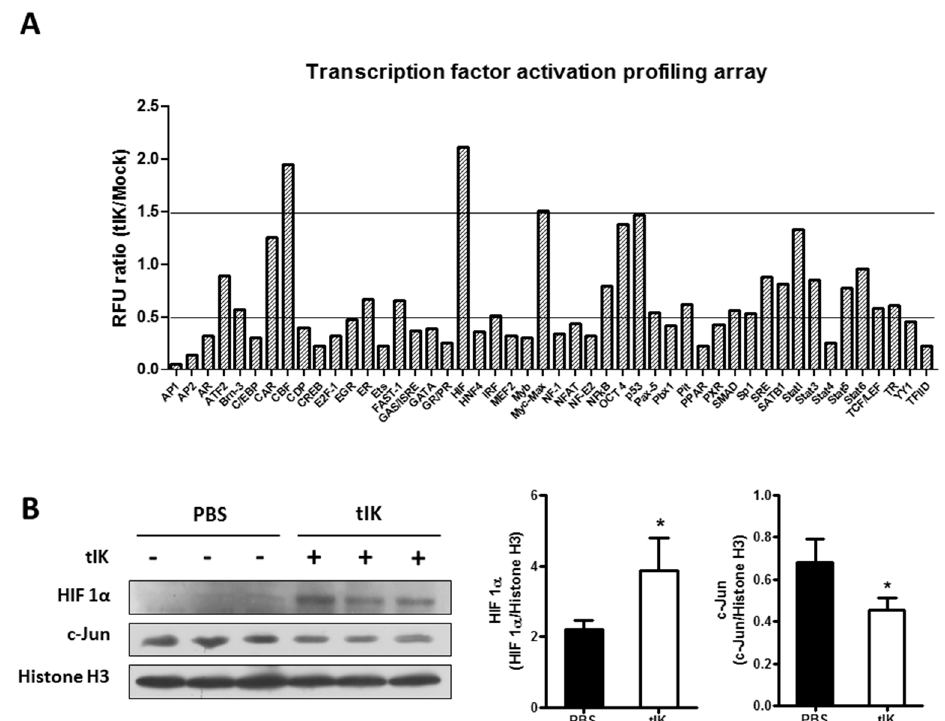
Figure 5. Treatment with tIK protein affects the activation of various transcription factors. ( A ) Nuclear extracts from CD4 + T cell treated with PBS or tIK protein for 8 h were used as samples for a plate array and the activation level of several transcription factors was compared between the PBS-treated group and the tIK protein-treated group. The RFU indicates the ratio of values for transcription factors in tIK-treated and control (PBS-treated) cells; ( B ) The expression level of HIF-1 α and c-Jun (AP-1 component) were confirmed by Western blotting. Nuclear extract was prepared as described for Figure 5A and used for confirmation. Data is represented as the mean ± SD ( n = 3), * p < 0.05.